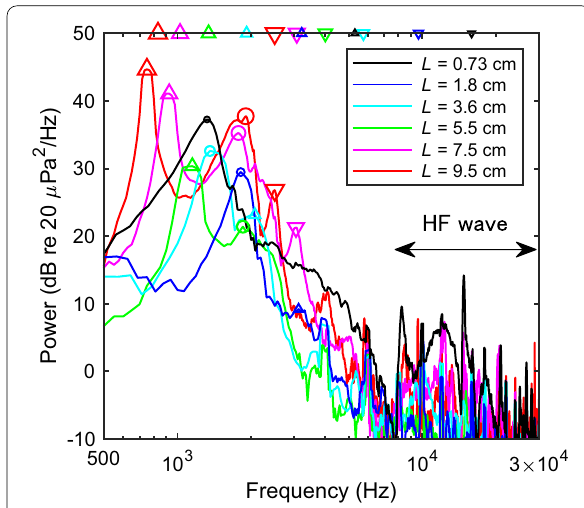
Fig. 15 Power spectra of the waveforms shown in Fig. 14. Bandstop filters were further applied at 2000 and 4000 Hz. (cid:31) , (cid:31) , and (cid:31) , indicate the peaks which we identified as air column resonances ( n = 0 , 1) and Helmholtz resonance, respectively. (cid:31) and (cid:31) plotted on the upper frequency axis indicate the f A calculated from Eq. (20) using n = 0,1 and their sizes correspond to L